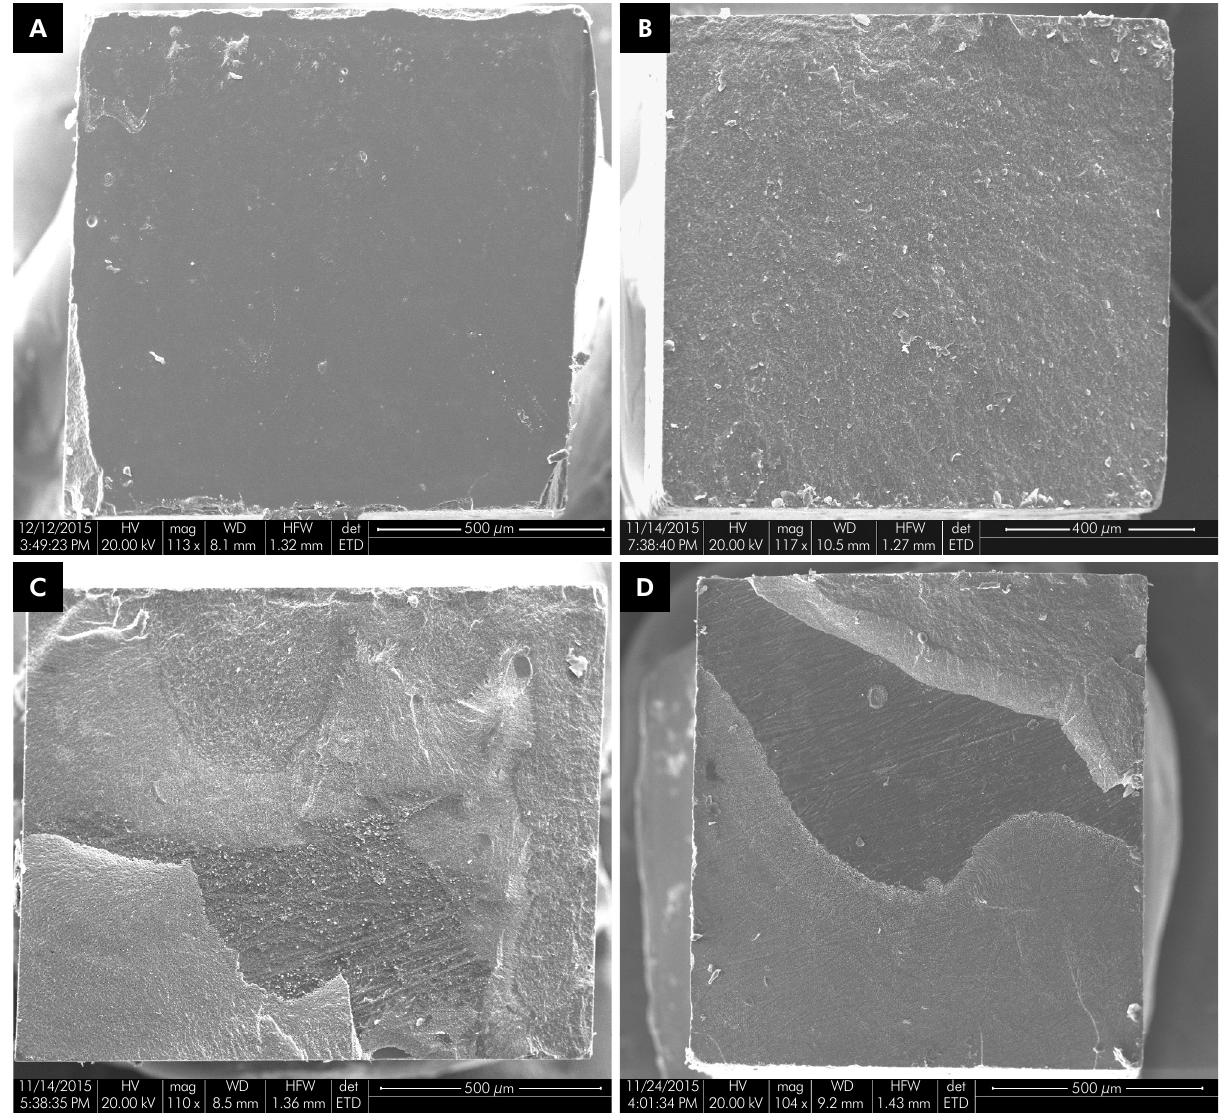
Figure 2. Representative FE-SEM of fractured EMX-dentin sticks. A) Adhesive failure; B) Cohesive failure within ceramic; C) Cohesive failure within dentin; D) mixed failure involving ceramic, adhesive interface and